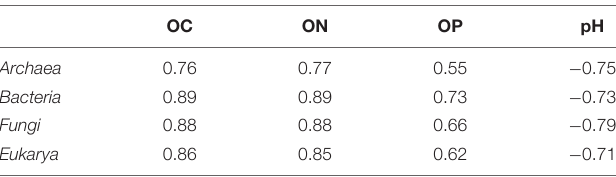
TABLE 2 | Spearman rank order correlation coefficients for SSU rRNA gene copy numbers g − 1 dry weight soil and soil properties of the soil